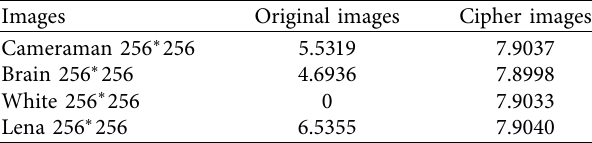
Table 7: The results of local Shannon